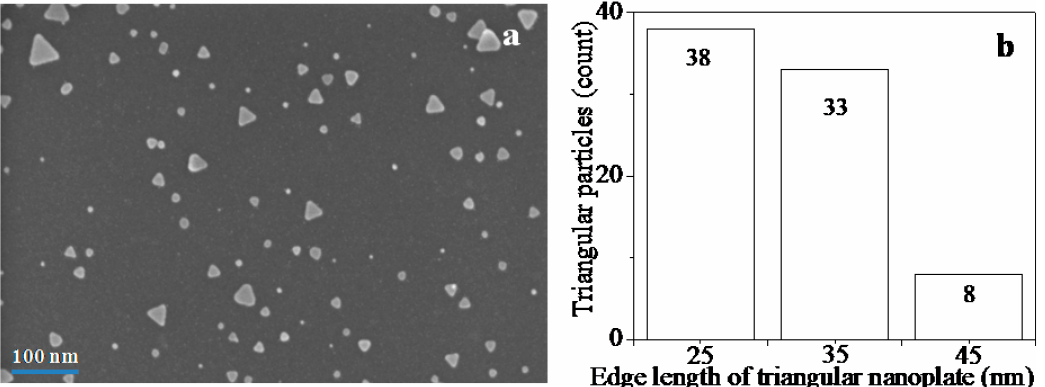
Figure 3. ( a ) FESEM image of nanoplate film on silicon surface after 15 min of exposure; ( b ) Bar chart for edge length of triangular nanoplates for 15 min growth on surface. The edge length of 25 means the size of nanoplates was from 20 to 30 nm, 35 from 30 to 40 nm, and 45 from 40 to 50